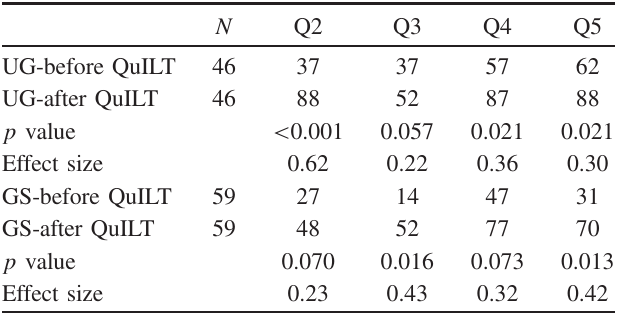
(GS) students who used WPI reasoning among those who provided reasoning on DSE polarizer questions 2 – 5 and p values and effect sizes for comparing these percentages from before to after working on the DSE QuILT via MacNemar ’ s